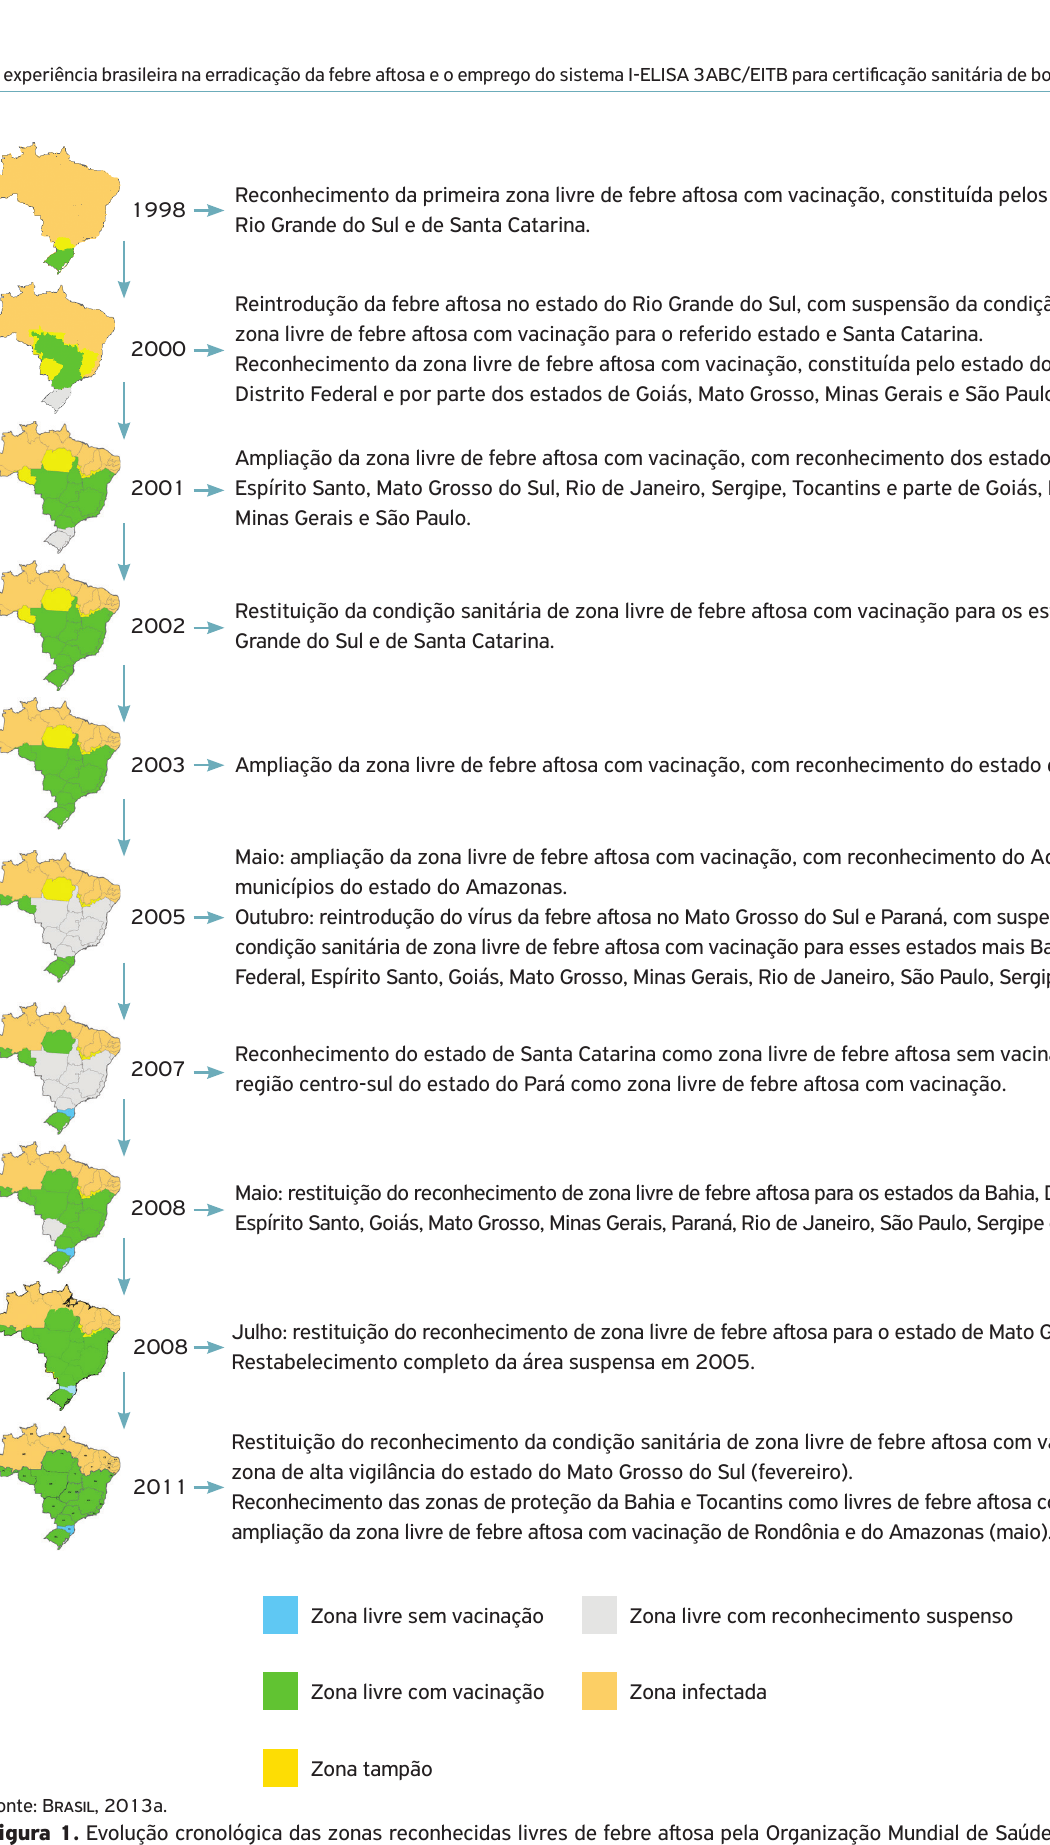
Figura 1. Evolução cronológica das zonas reconhecidas livres de febre aft osa pela Organização Mundial de Saúde Animal, Brasil, 1998 a